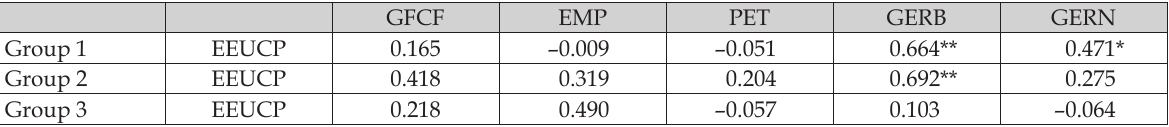
Table 6. Correlations between EU funding and development indicators in groups of CEE